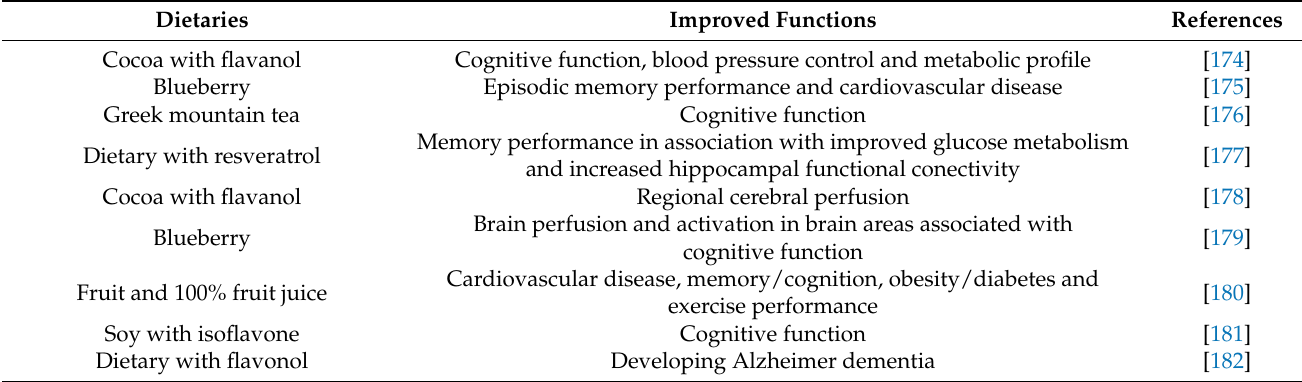
Table 4. Improvement of functions in older adults by daily intake of